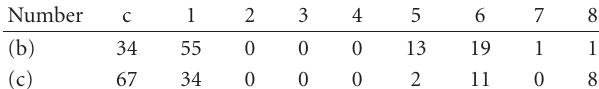
Table 1: Classification by voting method.